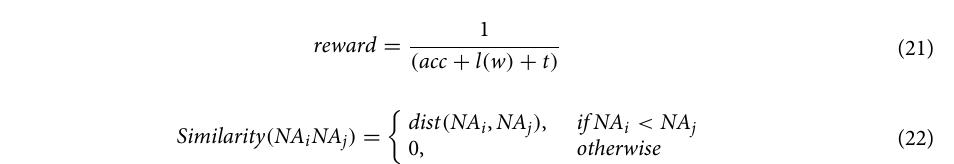
Figure 4. Sample images from the BreakHis datasets showing ( a ) adenosis, ( b ) ductal carcinoma, ( c ) mucinous carcinoma, and ( d ) papillary carcinoma malignant cases. Each column shows the magnification of samples for ( a )–( d ) in 40X, 100X, 200X, and 400X accordingly. The H&E stain the nuclei with a dark purple (Hematoxylin) and the cytoplasm with a light pink